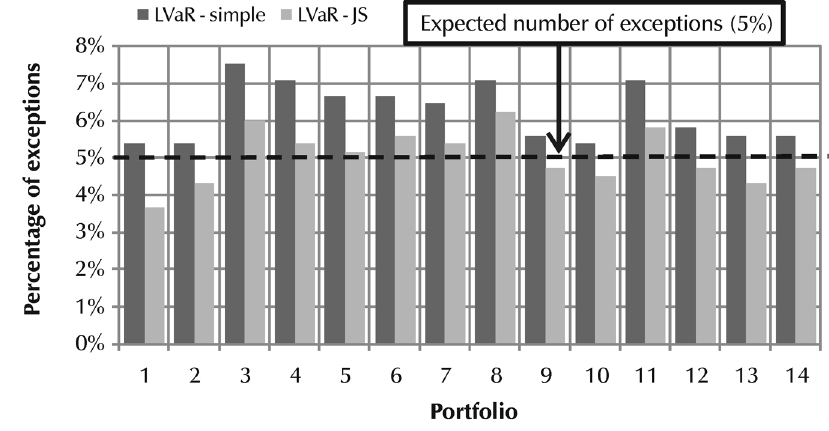
measures of liquidity VaR. The results are shown in Figure 4 below. For each of the 14 portfolios here investigated – each using 466 data points – the LVaR measure underestimated actual simple losses to a greater extent than the LVaR . JS For LVaR the average underestimation simple was 7.5 per cent with a standard deviation, v = 3.1 per cent while for LVaR the average JS underestimation was only 4.2 per cent with v = 1.9 per